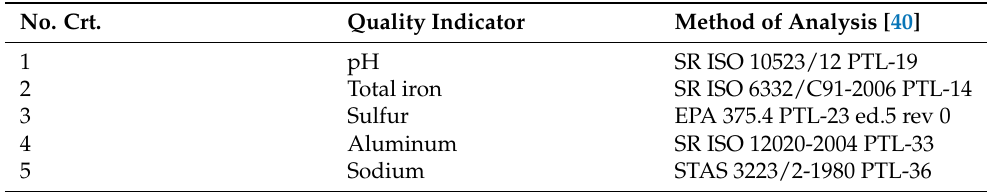
Table 2. Methods used for groundwater quality indicators.